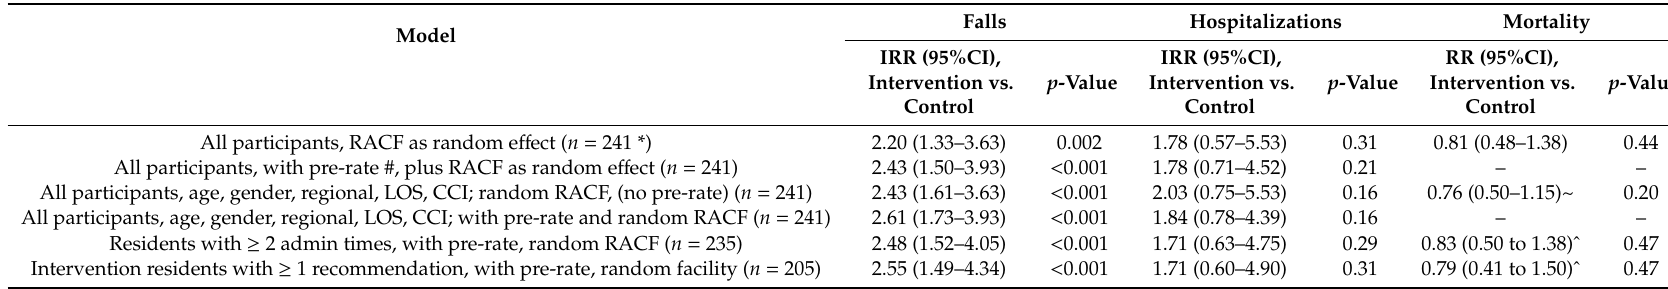
Table 3. Adjusted di ff erences in health outcomes in the intervention versus comparison arms at 12 months post-study entry.